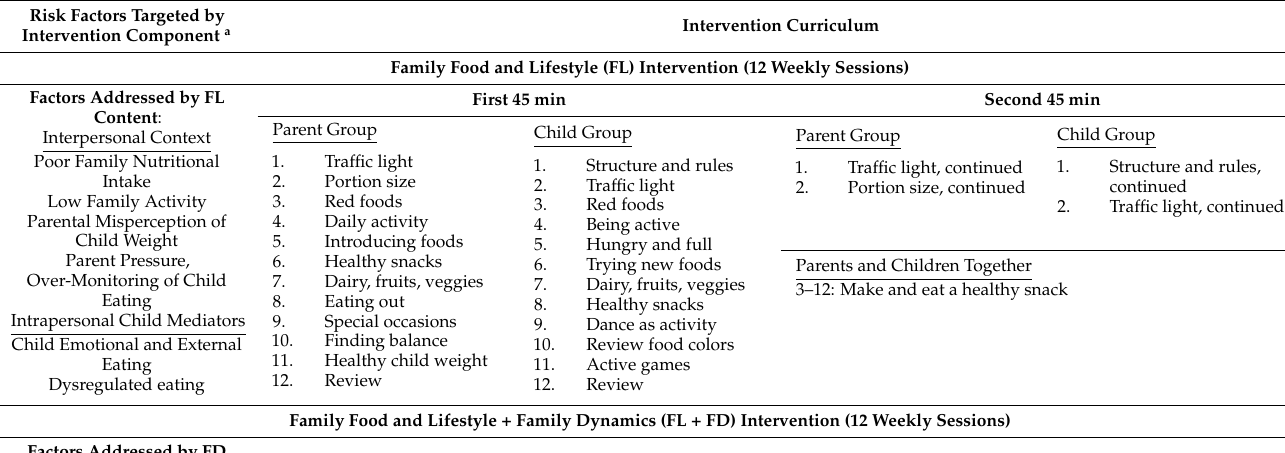
Table 3. Summary of the Families and Schools for Health Intervention